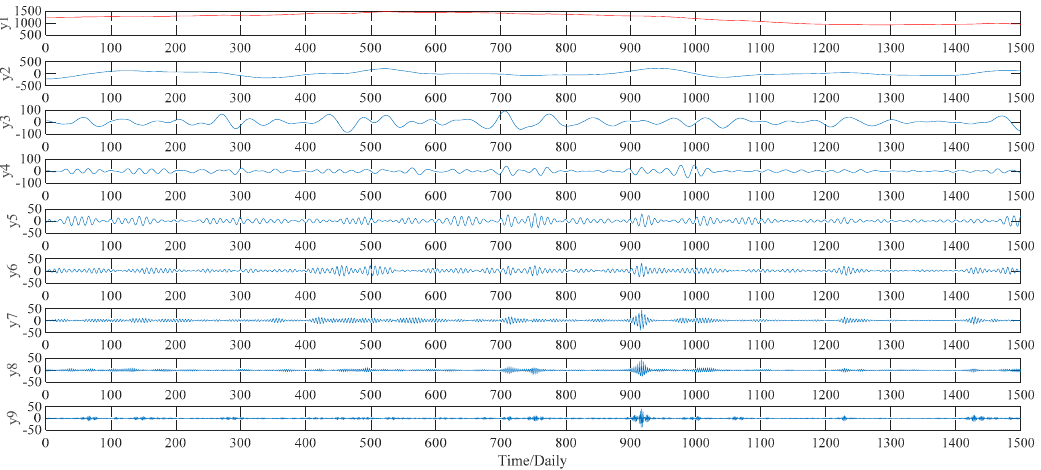
Figure 22. Decomposition results of the VMD method (soybean).